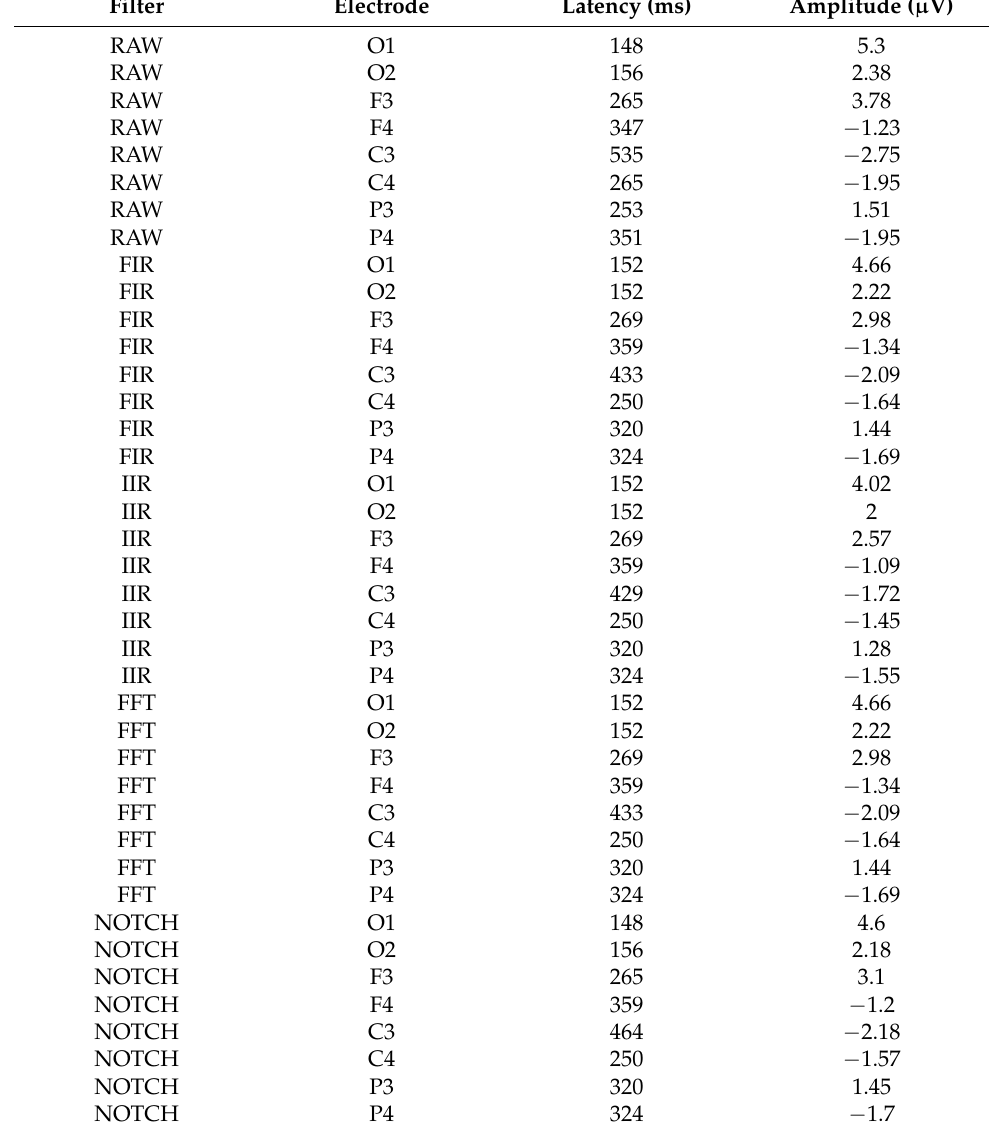
Table 3. Numerical values (latency and amplitude) for finger 2, for the right hand, for one person.